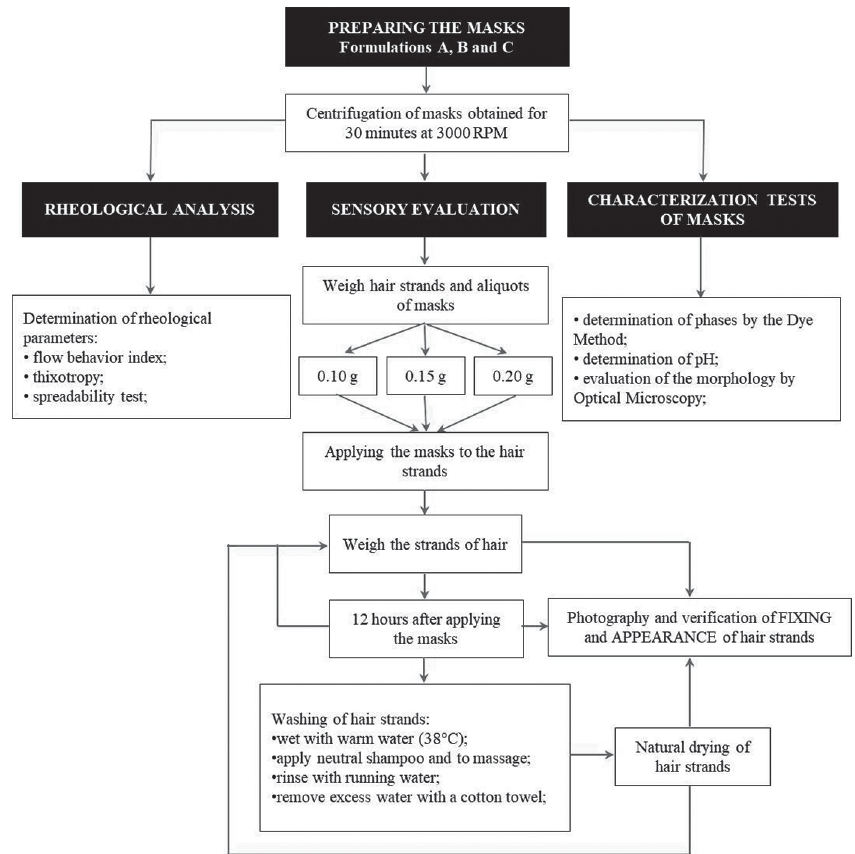
FIGURE 1 - Summary of the